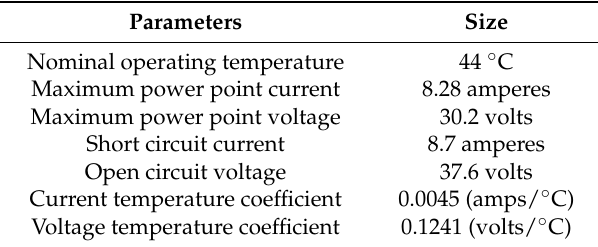
Table 5. Solar PV